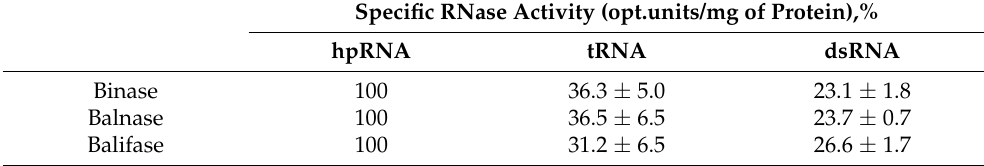
Table 1. Catalytic activity of RNases towards high-polymeric RNA (hpRNA), transport RNA (tRNA) and double-stranded RNA (dsRNA). Activity of each RNase towards hpRNA was taken as 100%. Specific RNase Activity (opt.units/mg of